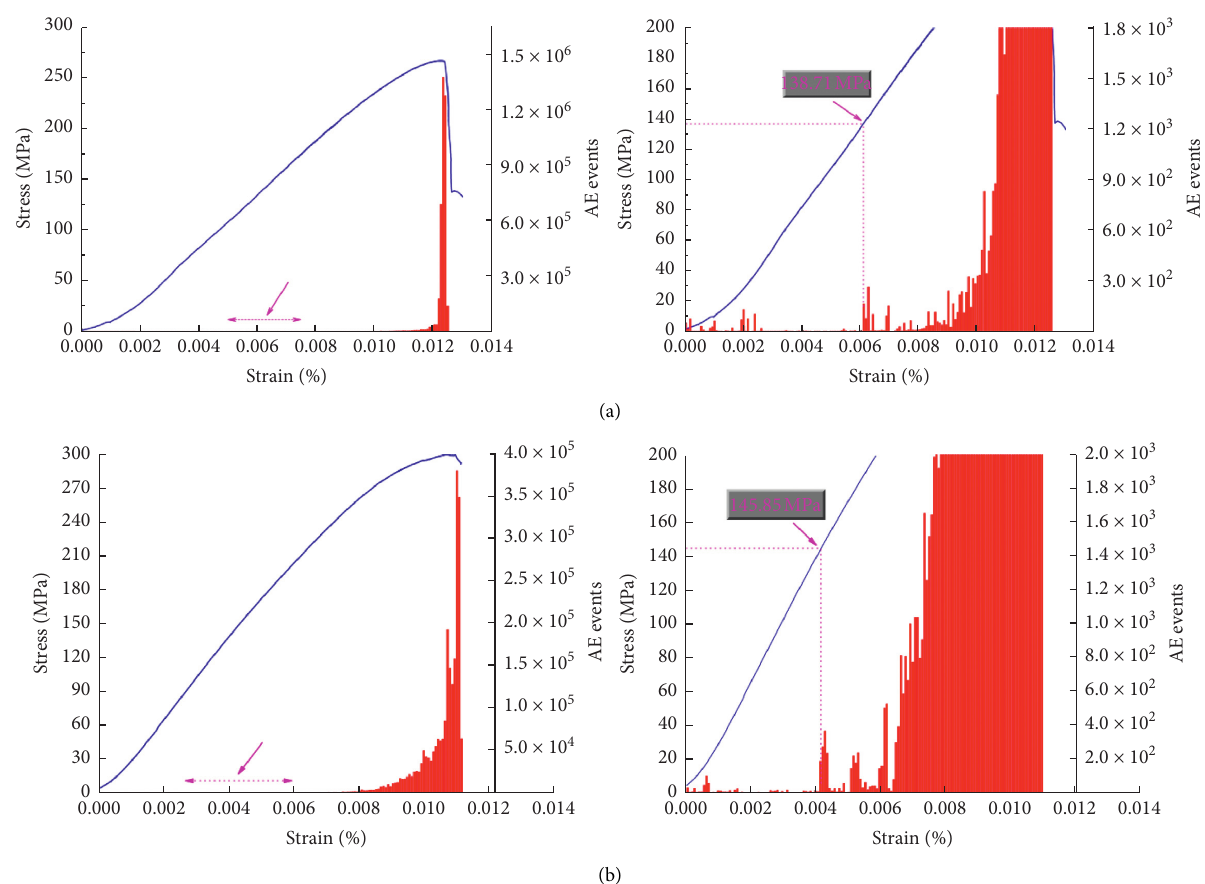
Figure 3: Typical stress-strain curve with AE events and its partial diagram of an initial crack point. (a) No.1 testing specimen with 20MPa confining pressure. (b) No. 2 testing specimen with 20MPa confining pressure.